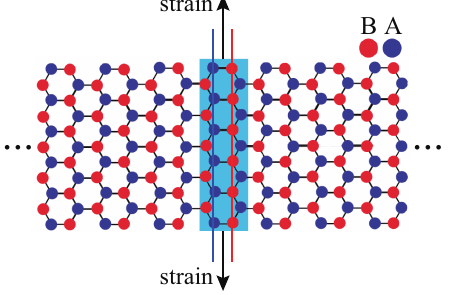
Figure 6. AGNR with local tensile strain applied perpendicular to ribbon direction in region D (blue area). A and B zigzag edge sites are shown on the blue and red